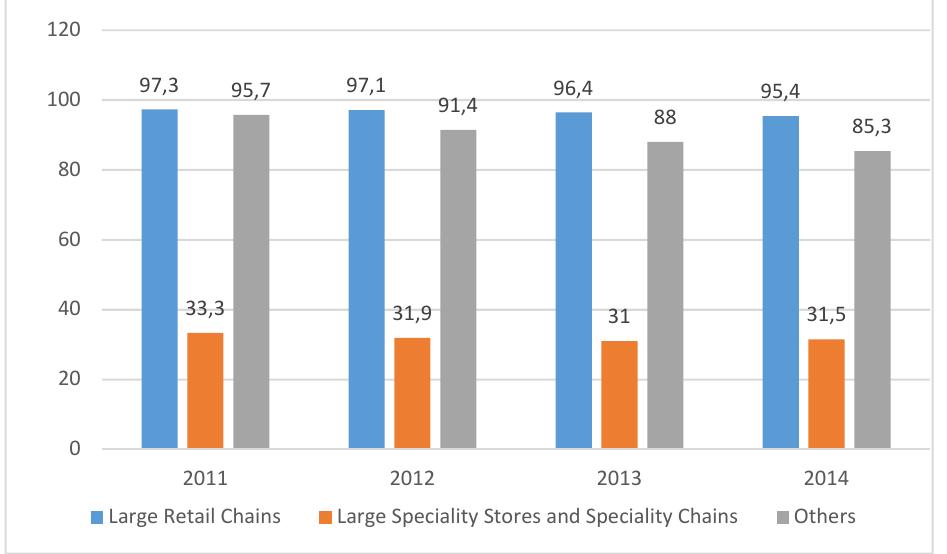
Source: Authors’ elaboration of DGM Consulting and Federdistibuzione